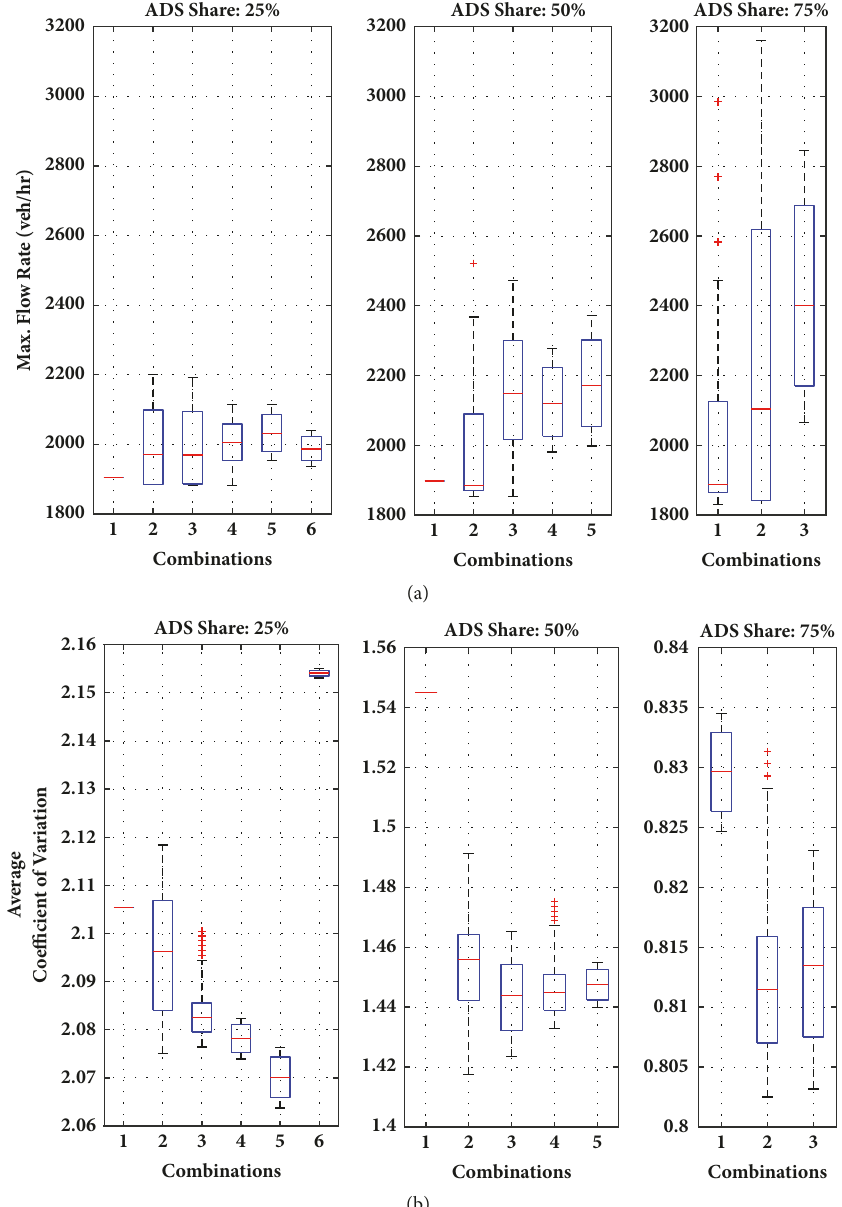
Figure 2: Influences of ADS vehicles’ position on (a) maximum flow rate and (b) average coefficient of variation of accelerations.